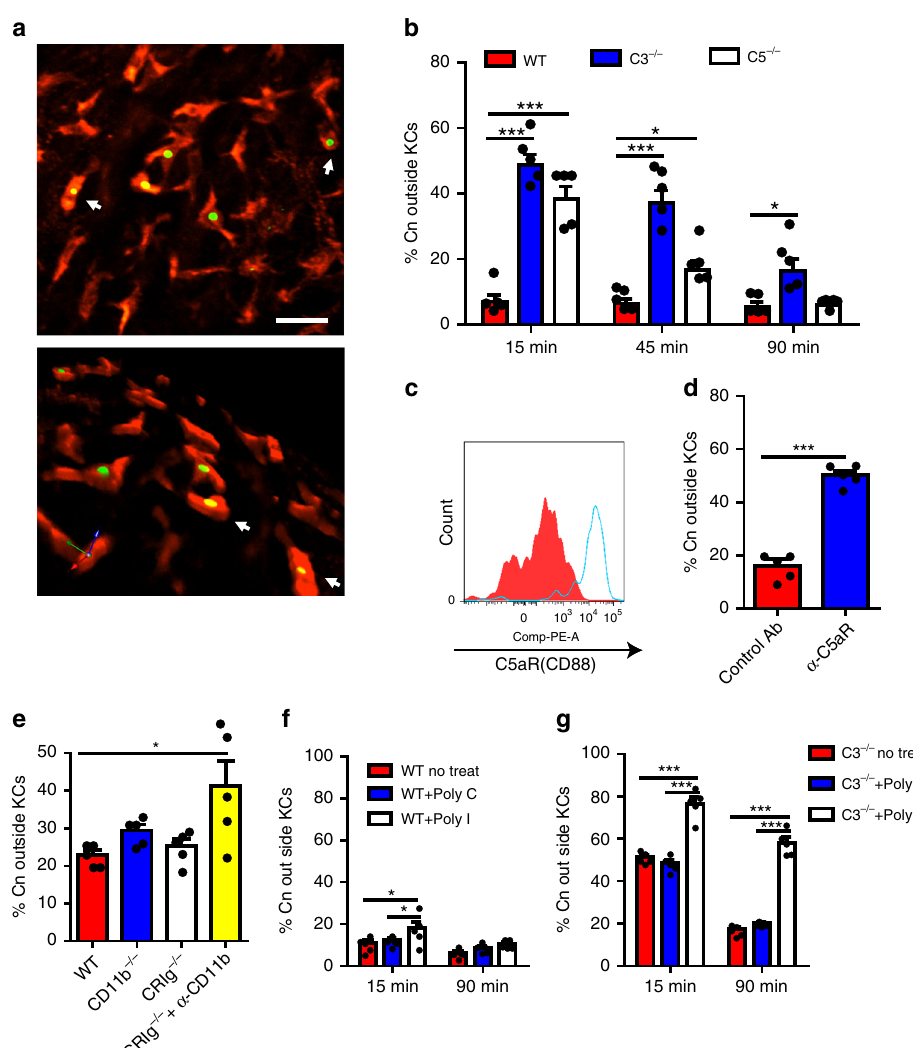
Fig. 5 C. neoformans is rapidly engulfed by KCs through multiple receptors. a IVM on the liver showing phagocytosis of C. neoformans (green) by KCs (red)